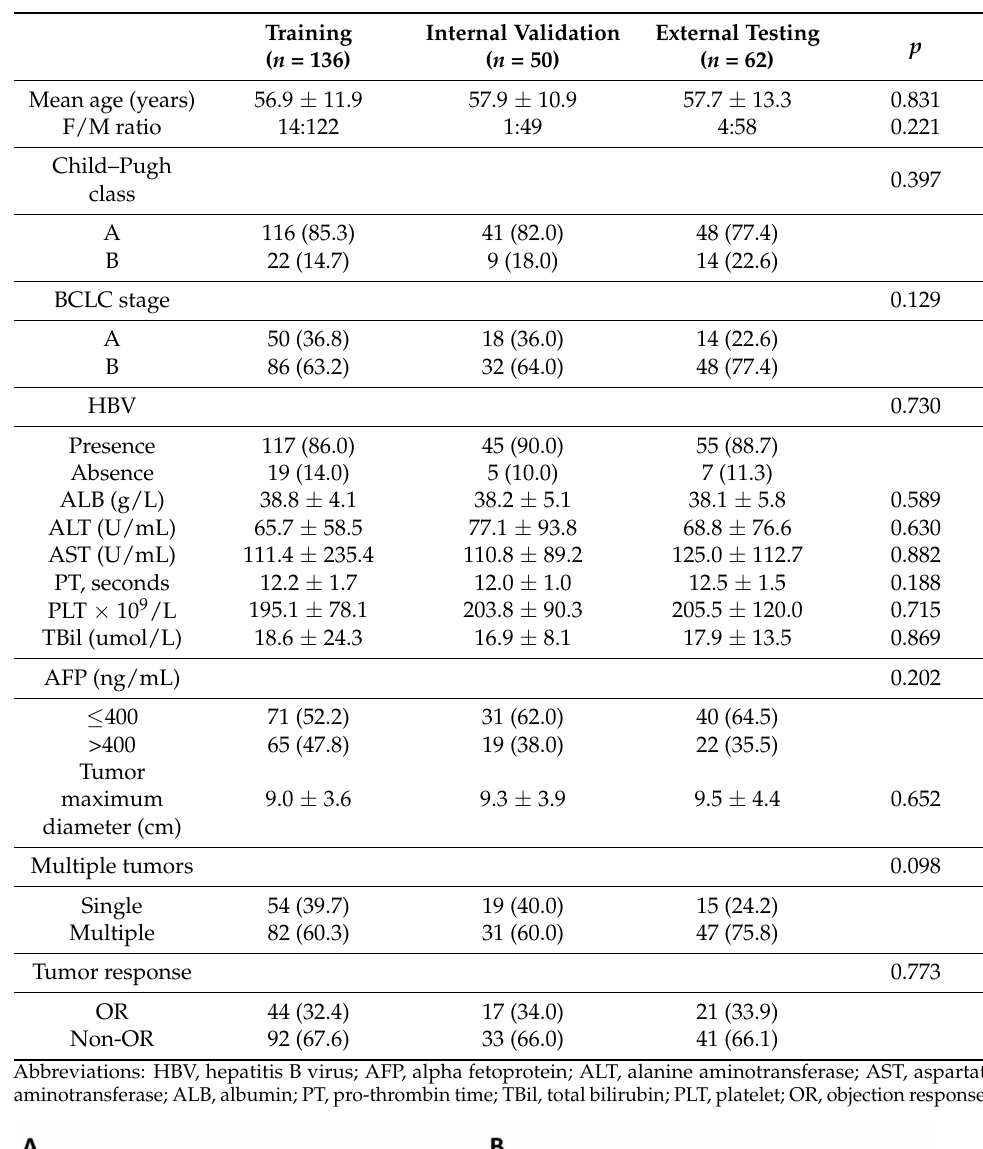
Table 2. Patient characteristics in the training, internal validation, and external testing cohorts.